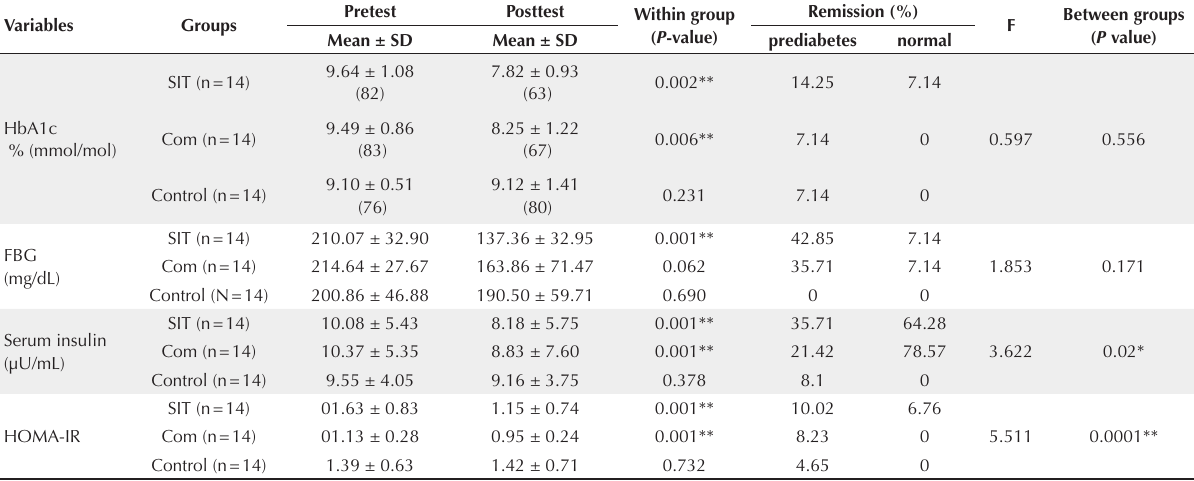
Table 3. The comparison of changes in the glycemic variables before and after 10 weeks of exercise training Variables Groups